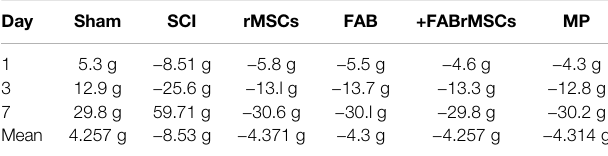
TABLE 3 | Comparison of weight variation between SCI groups. Average daily weight loss/gain over 7 days.